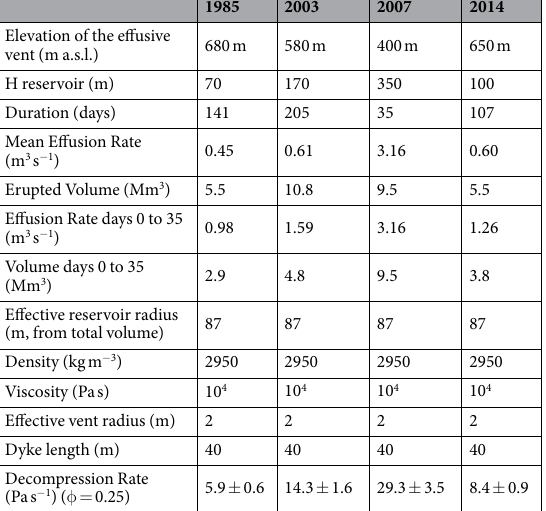
Table 1. Parameters related to the eruptive crises. Parameters of the effusive eruptions and data used in the gravity-driven discharge model (see Figure 1b). As reported in the text, most of the values (e.g., elevation of the effusive vents, vent radius, durations of the effusive eruptions) were directly observed during the effusive eruptions, while others (e.g., the total lava volumes, effusion rates) are represented as ranges because of both their uncertainties and natural variabilities; their associated errors are reported in the text.